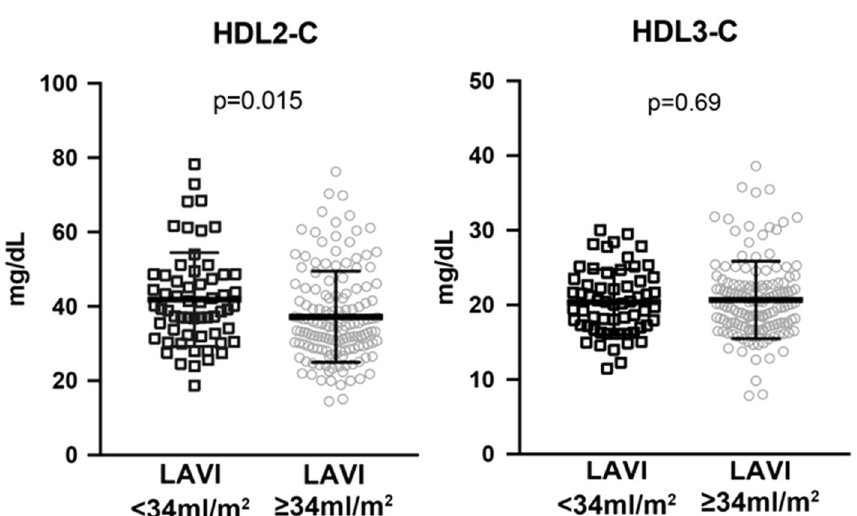
Figure 2. Plasma high-density lipoprotein2 and 3 -cholesterol level (HDL-2C and 3C) in patients with and without an enlarged left atrium (LAVI ≥ and < 34 mL/m 2 ). Subfractions of HDL, HDL2 and HDL3, were separated by ultracentrifugation and then cholesterol concentration was measured. Each open square/circle represents one participant. The horizontal lines indicate average ± standard deviation,